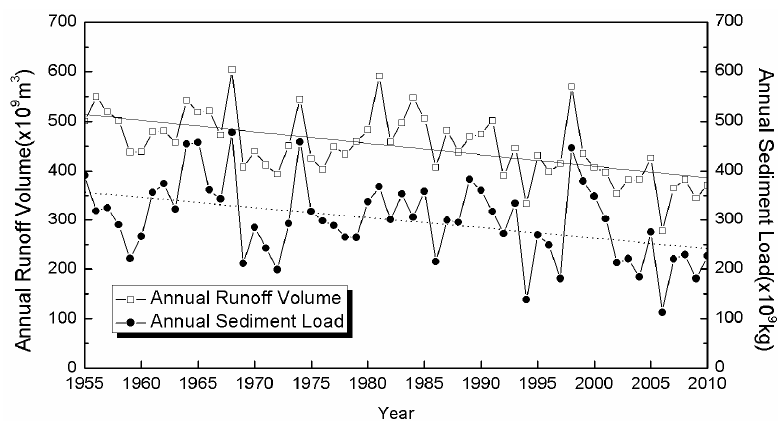
Figure 2. Annual runoff and sediment into the TGP.